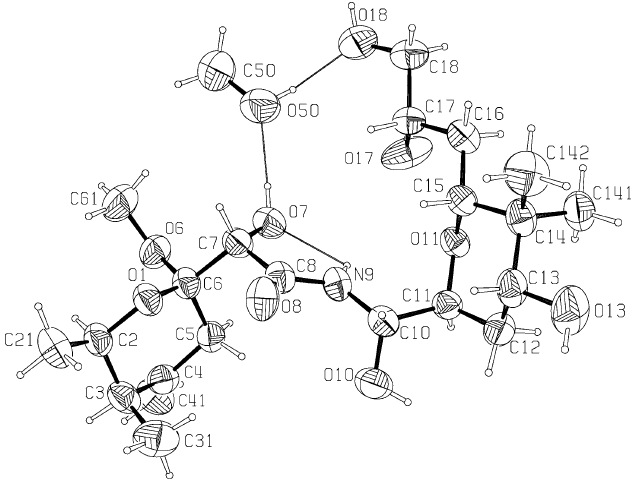
Figure 1 A view of the molecular structure of the title compound, with the atom labeling. Displacement ellipsoids are drawn at the 50% probability level. Hydrogen bonds are shown as thin black lines (see Table